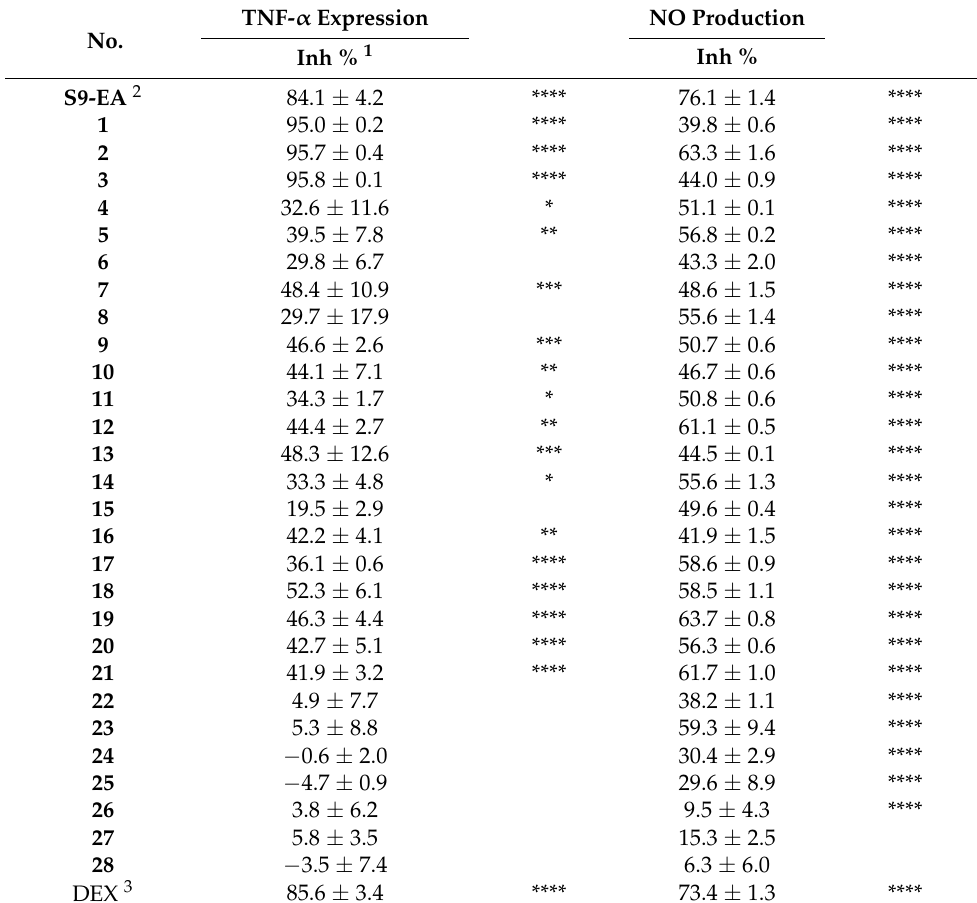
Table 8. Inhibitory effects of compounds 1 – 28 on TNF- α expression and NO production in LPS- induced dendritic